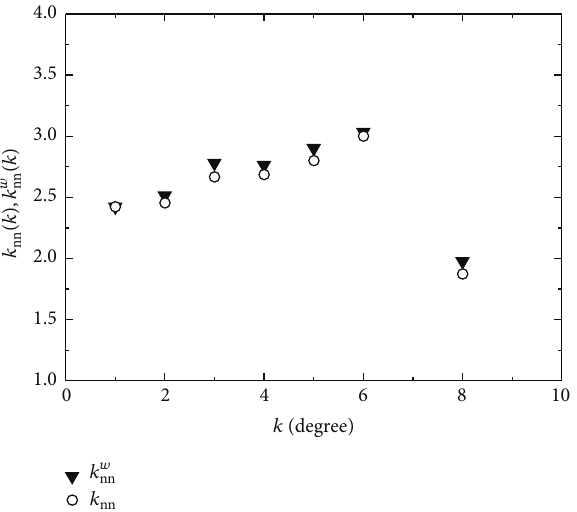
Figure 5: Degree-degree correlation of the RTS